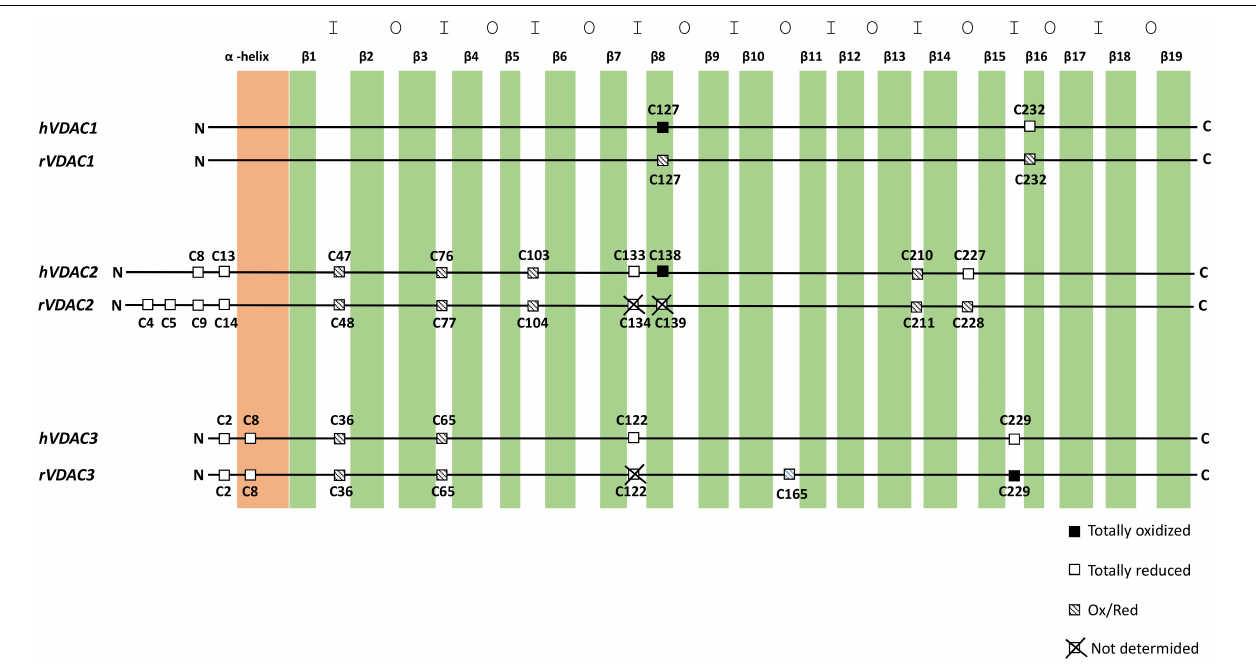
FIGURE 2 | Cysteine localization in the aligned sequences of human and rat VDAC isoforms. The N-terminal α -helix is shown in light orange, and β -strands are in green. The internal loops, that is, exposed to the intermembrane space, are indicated with I. The outer loops, that is, exposed to the cytosol, are indicated with